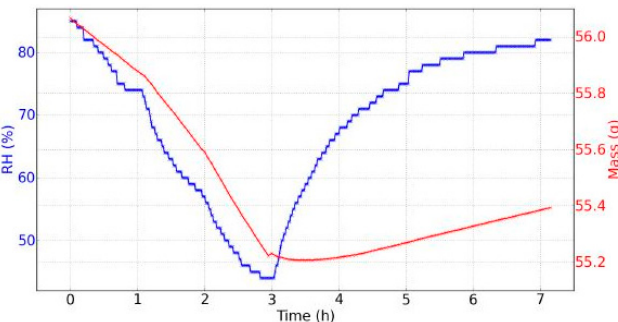
Figure 6. Evolution of the relative humidity (RH) and mass during seven hours, day 7 of experiments.